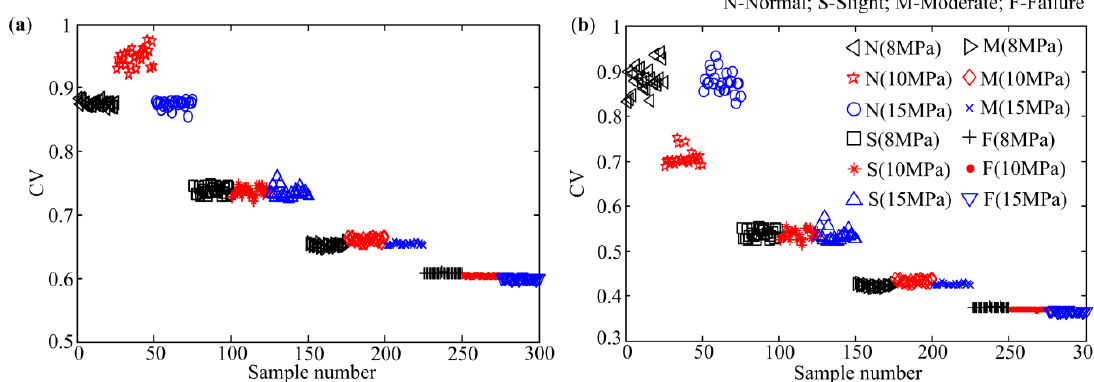
Figure 14. The self-organization mapping (SOM)-based recognition results for the different SOM parameters. ( a ) Scale parameter selects 0.5 and ( b ) scale parameter selects 0.2.